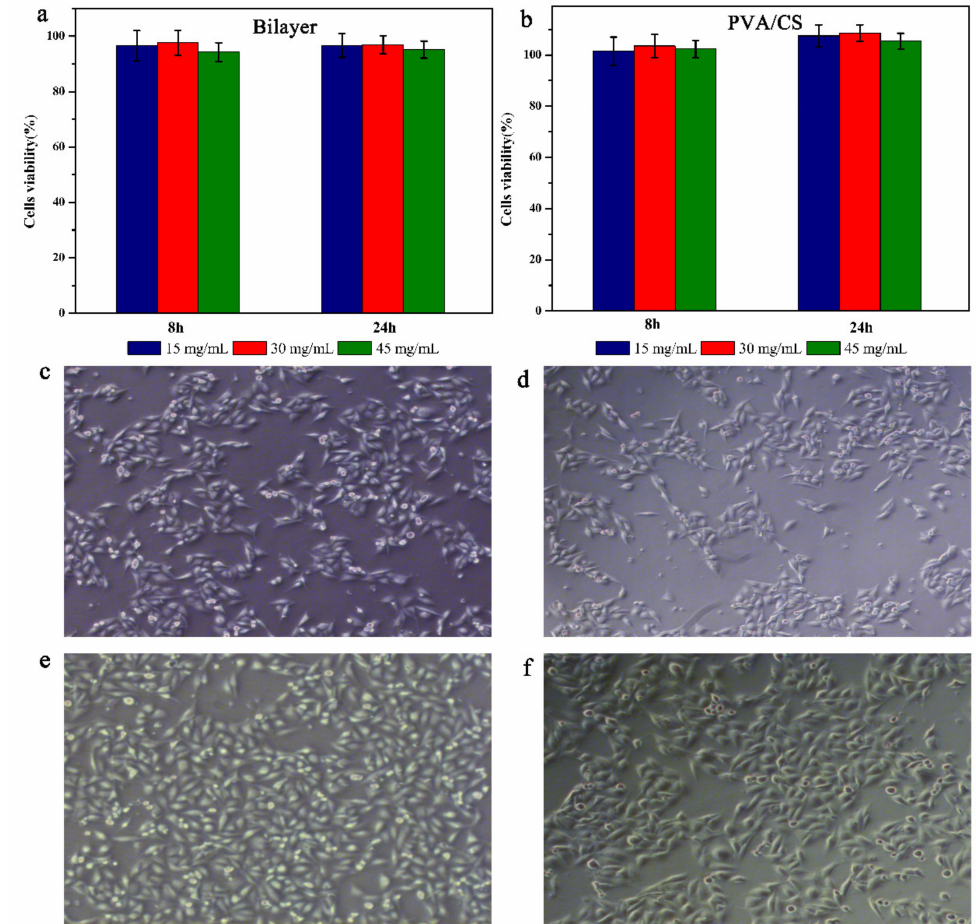
Figure 7. Viability of A549 cells treated with increasing concentrations of ( a ) PVA/CS and ( b ) bilayer hydrogels for 8, 16, and 24 h; Optical microscope images (100 × ) of ( c , d ) MDA-MB-231 cells and ( e , f ) A549 cells cultured on the surface of PVA/CS and bilayer